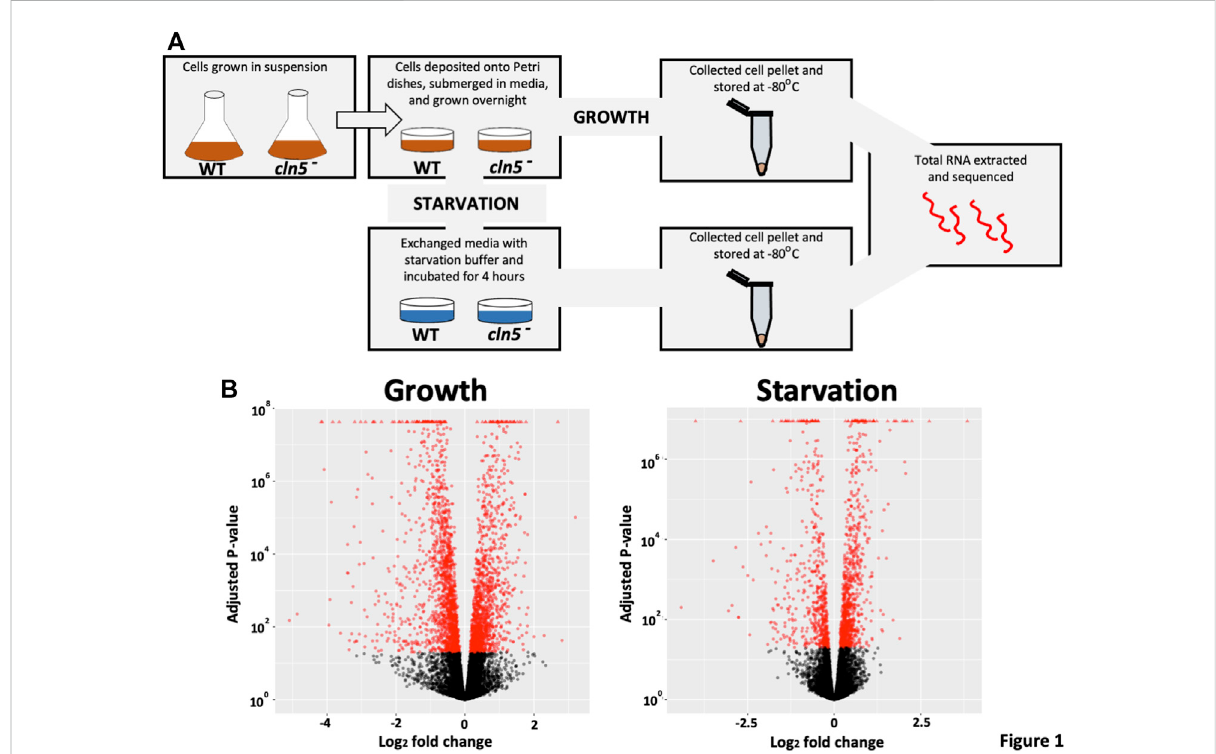
FIGURE 1 A pictorial schematic of the methods used to determine the effects of cln5 deletion on gene expression. (A) WT and cln5 - cells grown in suspension and in the mid-log phase of growth were deposited onto Petri dishes and grown overnight in HL5. Growth-phase cells were harvested after the overnight incubation, while starved cells were collected after a 4-hour incubation in KK2 buffer. All cell pellets were stored at − 80 ° C until RNA extraction was done. Extracted RNA samples were sequenced at The Hospital for Sick Children (Toronto, Ontario, Canada). (B) Following differential expression analysis via SARTools, volcano plots were generated to visualize the pro fi le of DEGs during growth and after 4 h of